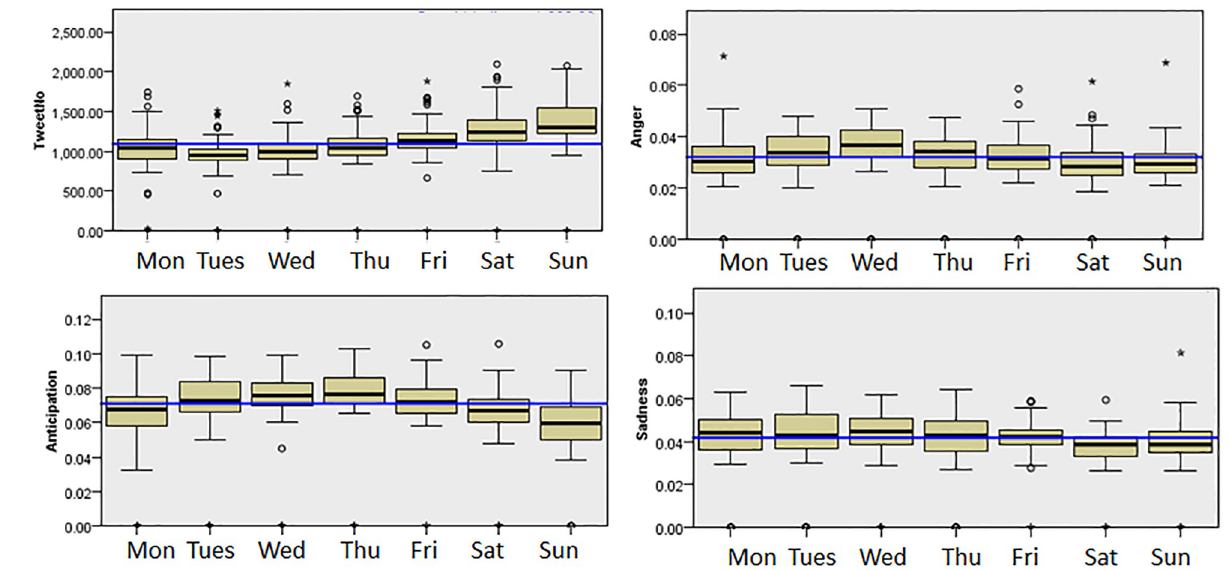
Fig 5. The emotions displayed on different days of the week in San